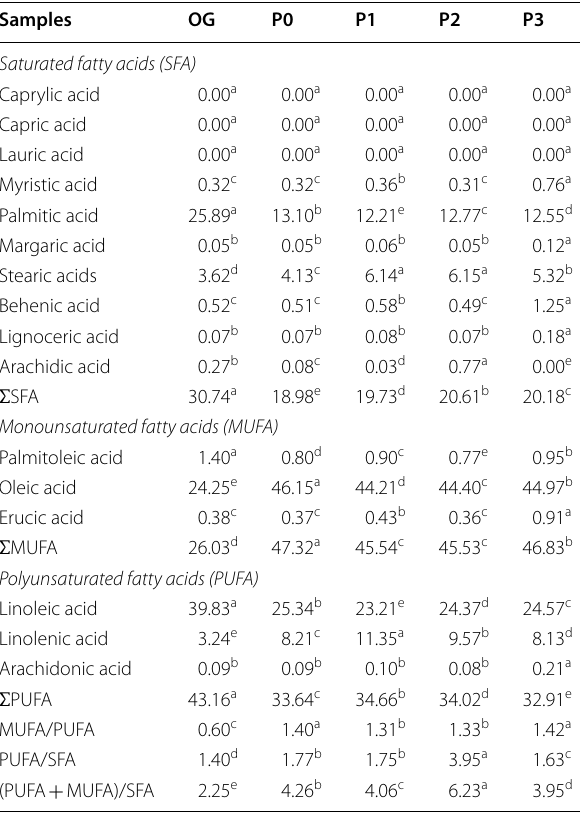
Table 4 Fatty acid profile (%) of therapeutic complementary